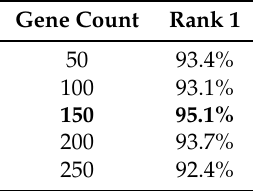
Table 2. Summary comparison of rank 1 accuracy between various gene counts used in the system.